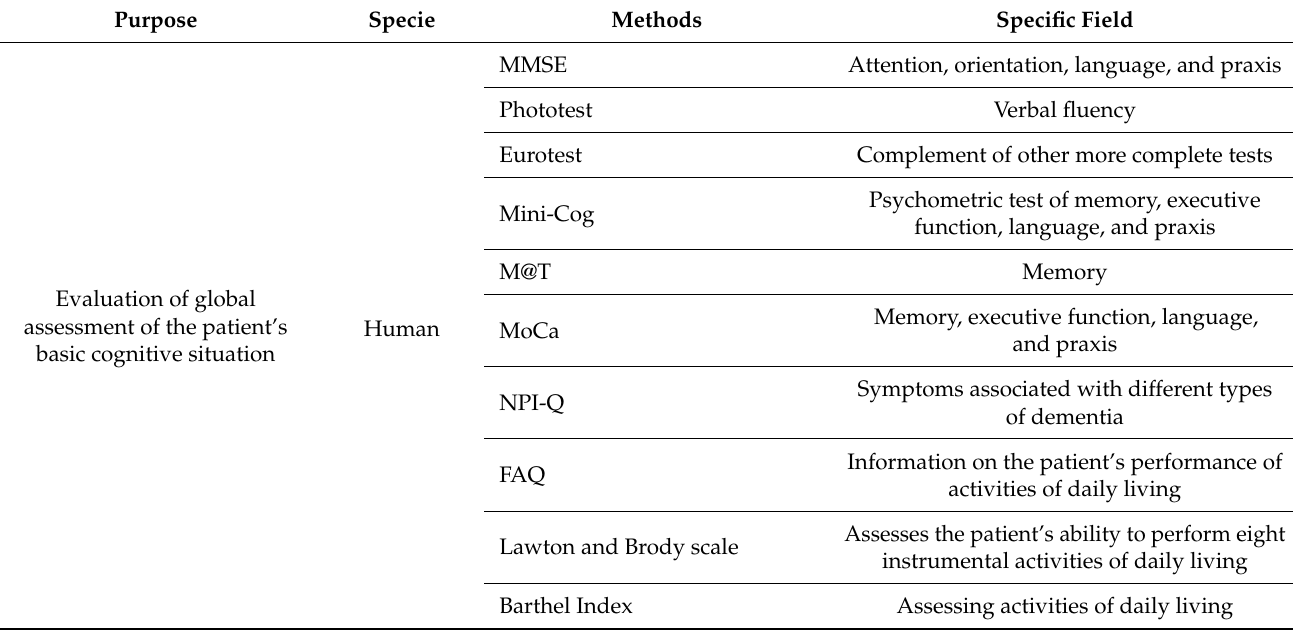
Table 1. Summary of the main tests used in human and rodents to evaluate cognitive